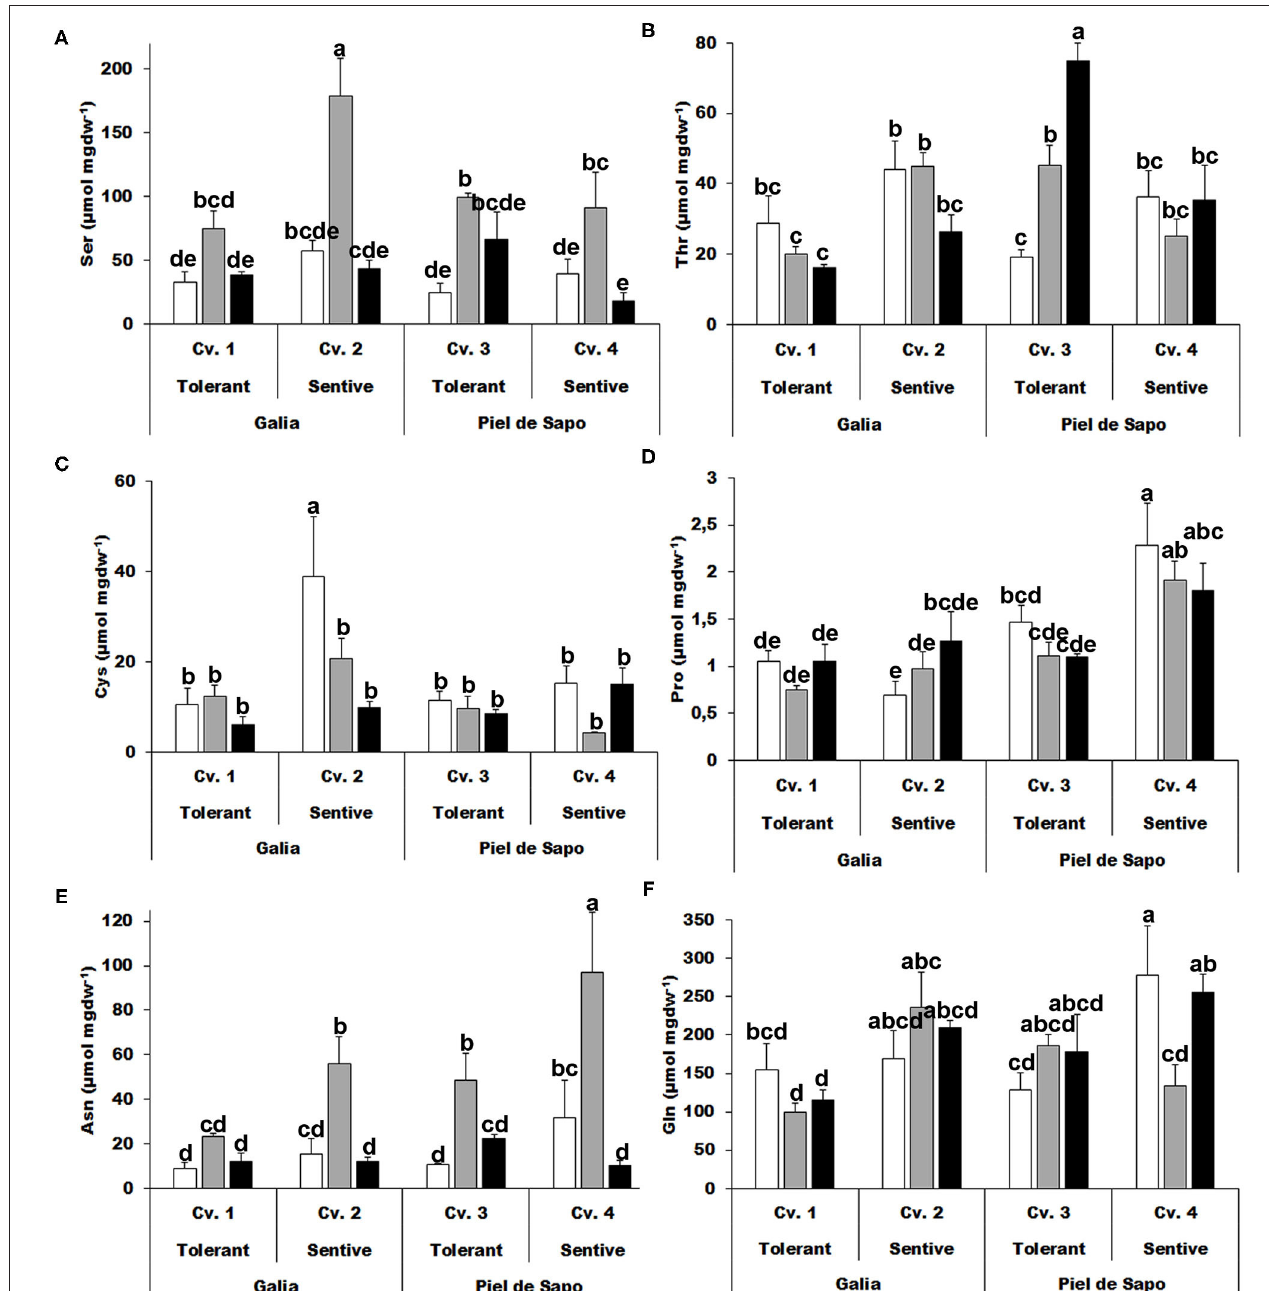
FIGURE 3 | Polar amino acids. Serine (Ser) (A) ; threonine (Thr) (B) ; cysteine (Cys) (C) ; proline (Pro) (D) ; asparagine (Asn) (E) ; and glutamine (Gln) (F) of Galia tolerant genotype (Cv. 1), Galia sensitive genotype (Cv. 2), Piel de Sapo tolerant genotype (Cv. 3), or Piel de Sapo sensitive genotype (Cv. 4) under control (white bars), salt stress (gray bars), and drought stress (black bars) conditions. Data with different letters differ significantly ( p < 0.05), as determined by Duncan’s MRT test ( n = 3). Scale bars are mean ± SE. Experiment was replicated with similar